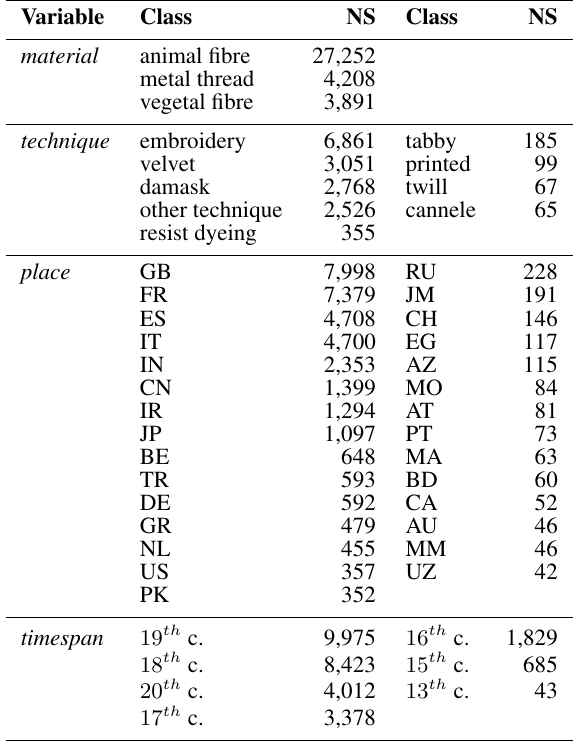
Table 1. Statistics of the distribution of samples for the SILKNOW dataset. Variable : name of the variable considered; Class : classes differentiated for each variables; NS : number of samples for a class.